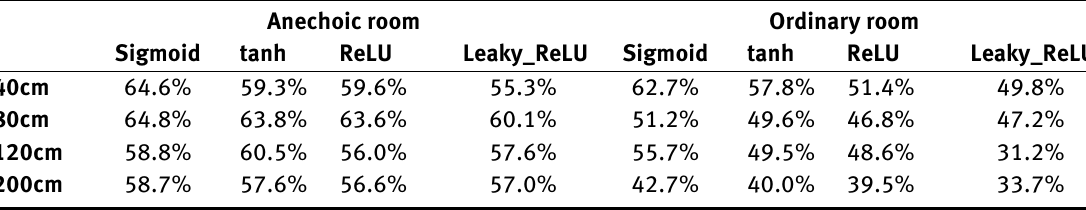
Table 5: Experimental results based on Net1